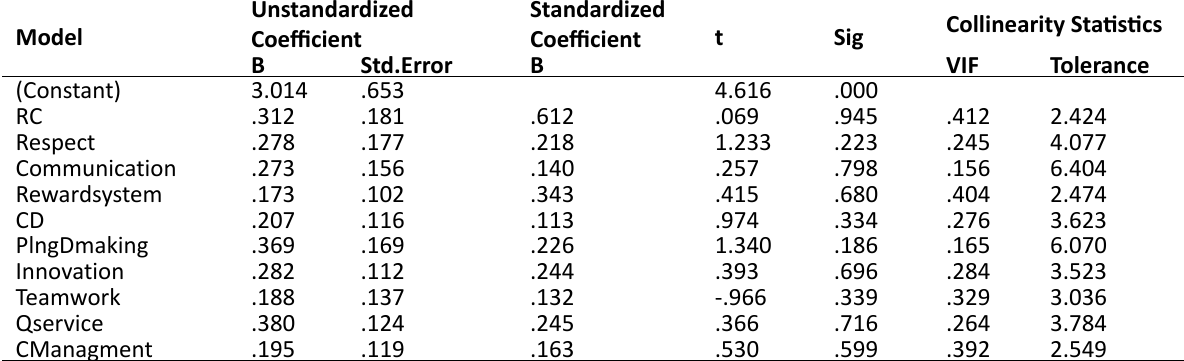
Table 7. Co-efficient